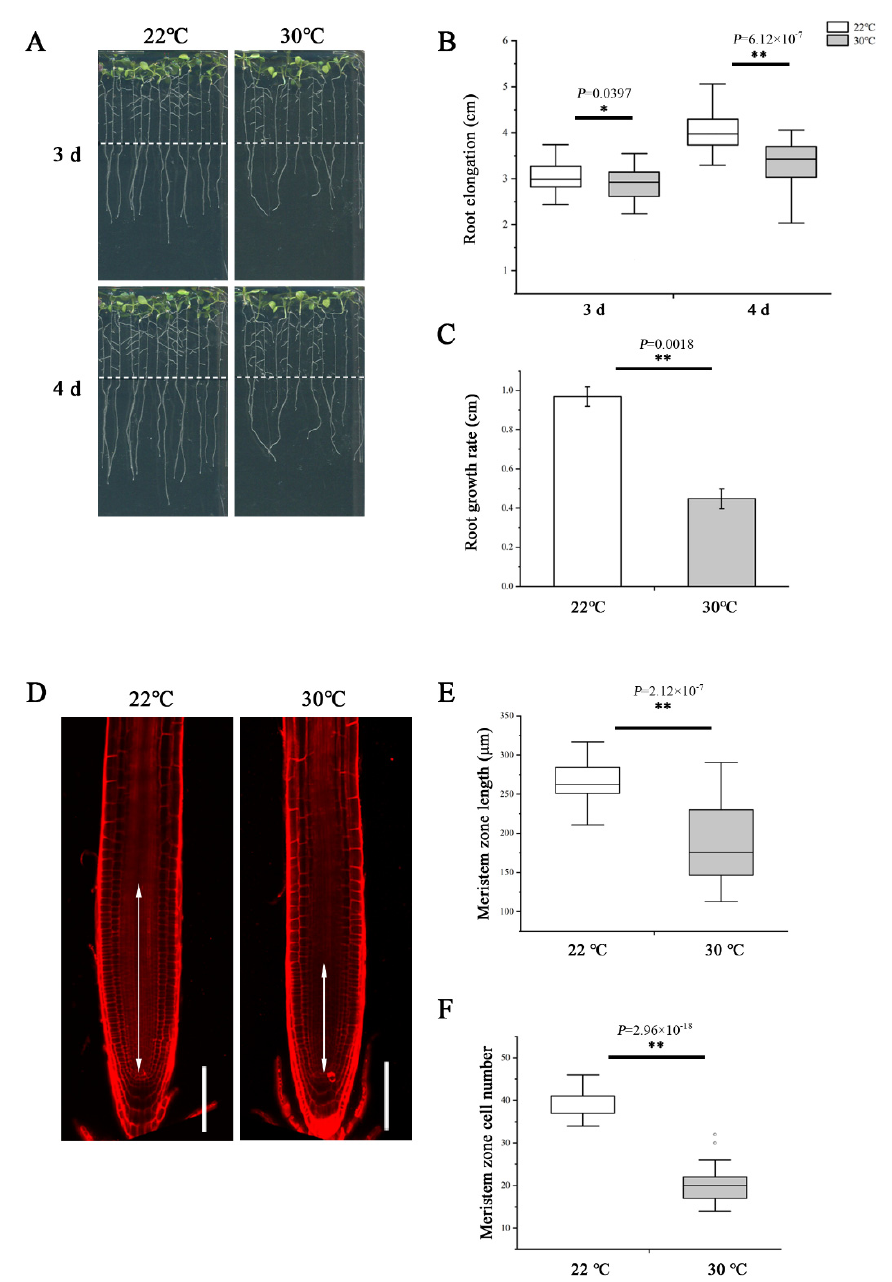
Figure 1. Heat stress reduces root meristem size in Arabidopsis thaliana . ( A ) Five-day-old wild-type (WT) seedlings grown on 1/2 MS medium were transferred to 22 °C and 30 °C and cultivated vertically for 3 d and 4 d and photographed. Dashed lines show the initial positions of root tips after being transferred. ( B ) Quantification of the length of newly grown primary roots in A, n > 34. ( C ) Quantification of the growth rate in A. The data are means ± SE. ( D ) Five-day-old roots of WT were transferred to 22 °C and 30 °C for 48 h and stained with propidium iodide to visualize the cell walls. Double arrows indicate the meristem length (from the cortical initial cell to the first elongated cell in the cortex layer). Scale bars = 100 μ m. ( E ) Quantification of the root meristem length in D, n > 20. ( F ) Quantification of the cell number of meristem in D, n > 20. In the box plots ( B , E , F ), the boxes indicate the first and third quartiles, and the whiskers indicate the minimum and maximum values. The black lines within the boxes indicate the median values. Outliers are shown as dots. ** p < 0.01; * p < 0.05 (two-tailed, two-sample t -test).